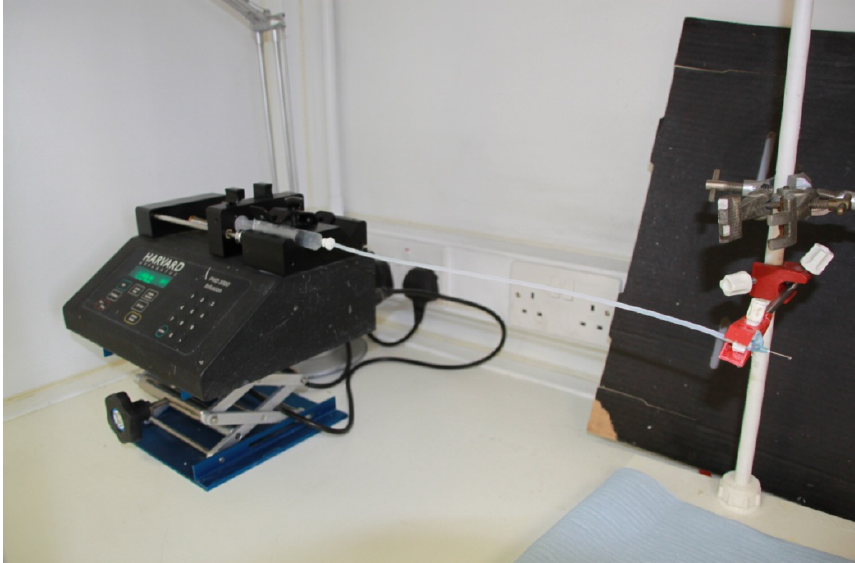
Figure 12. The electrospinning setup showing the syringe, needle and syringe